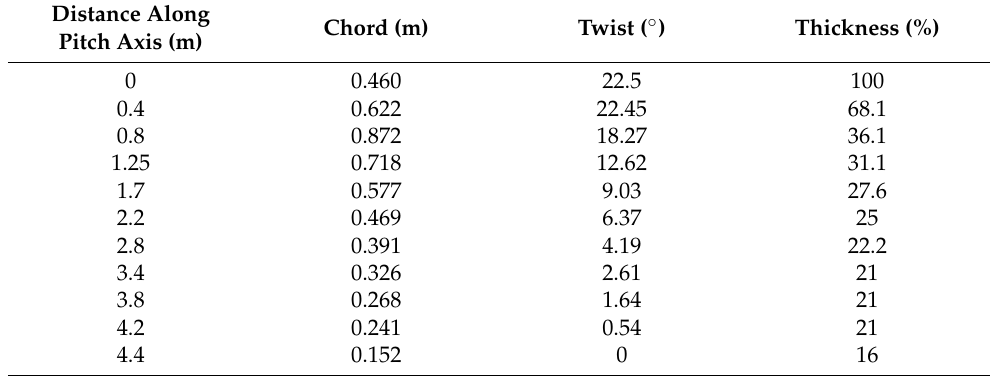
Table 2. 120 kW tidal current turbine blade geometrical parameter distributions along the